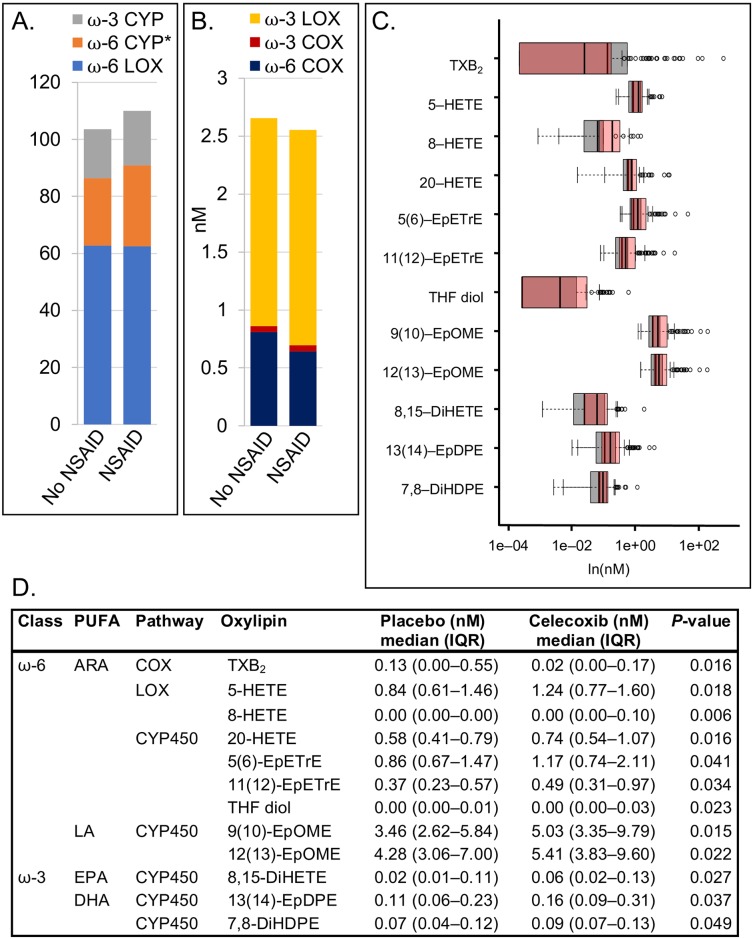
No NSAID (n = 49) versus any NSAID (aspirin and/or celecoxib; n = 136) among all participants.(A) Summed oxylipins from ω-3 CYP450, ω-6 CYP450, and ω-6 LOX pathway arms. Asterisk (*) indicates P = 0.036. (B) Summed oxylipins from ω-3 LOX, ω-3 COX, and ω-6 COX pathways arms. Note that A and B are on different scales. Different colors represent the sum of all quantified oxylipins in a given pathway arm. (C) Overlapping box plots showing significantly different individual oxylipins between NSAID non-users (gray) and users (pink). (D) Median (IQR) levels of oxylipins that are significantly different between groups, with Wilcoxon rank-sum test P-values. Note that the median value for 8-HETE is below the limit of quantitation (< 0.0008 nM).